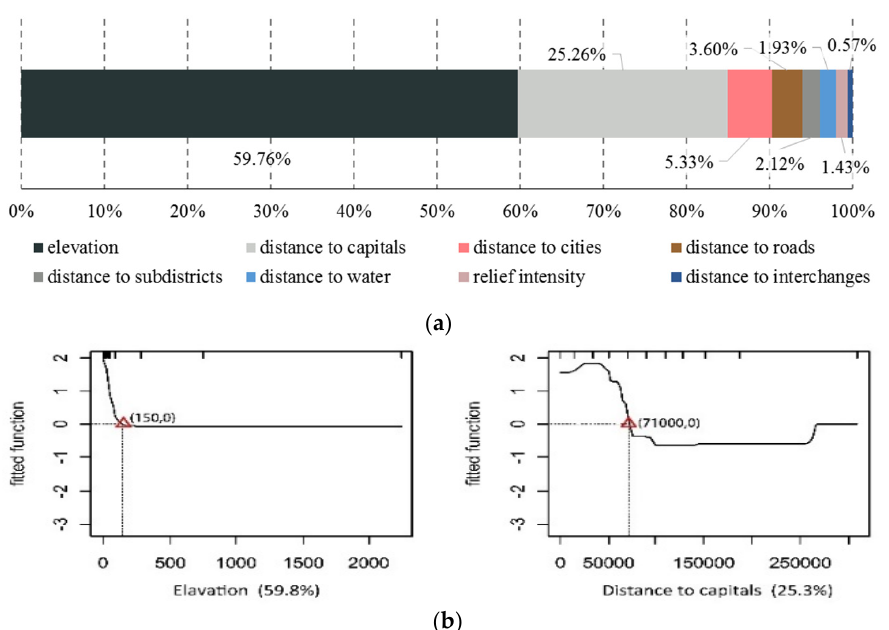
Figure 14. Factor contribution ranking and marginal effect of LS–PS. ( a ) Contribution degree of factors; ( b ) marginal effect of factor with a contribution degree over 10%.